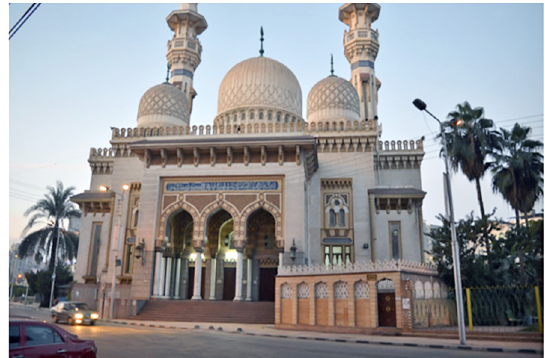
Figure 1. El-Nasr Mosque façade, Mansoura city, Egypt